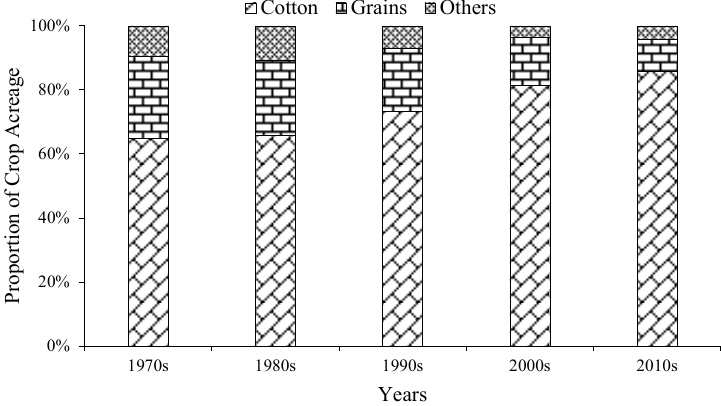
Figure 3. Variation of crop planting pattern during the 1970s to 2010s.